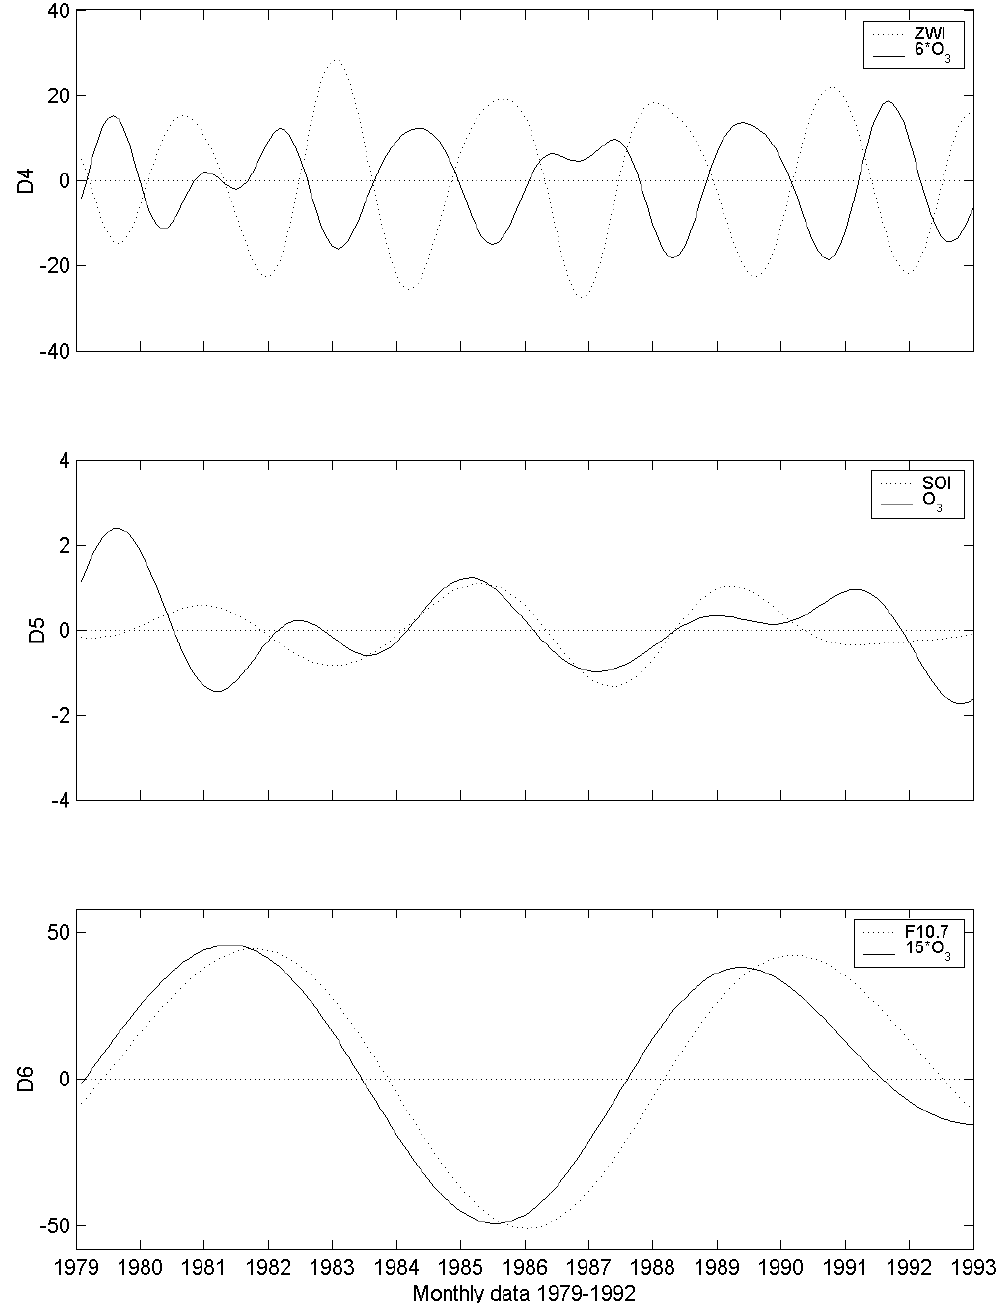
Fig. 2. Meyer wavelet decomposition frequency levels: D 4 for zonal wind index and global total ozone (multiplied by 6 for better visual- ization), top panel; D 5 for SOI and global ozone, middle panel; D 6 for F 10 . 7 and global ozone (multiplied by 15 for better visualization), bottom panel, for the period Figure 2 – Meyer wavelet decomposition frequency levels: D for zonal wind index and 4 for SOI and global total ozone (multiplied by 6 for better visualization), top panel; D 5 global ozone, middle panel; D for F and global ozone (multiplied by 15 for better 6 10.7 visualization), bottom panel, for the period 1979-1992.